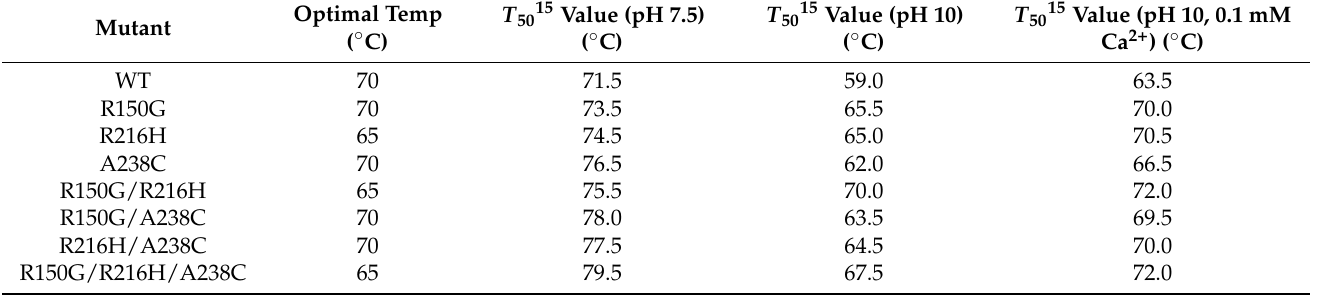
Table 3. Optimal temperature and T 5015 value of the wild-type BacPelA and mutants.